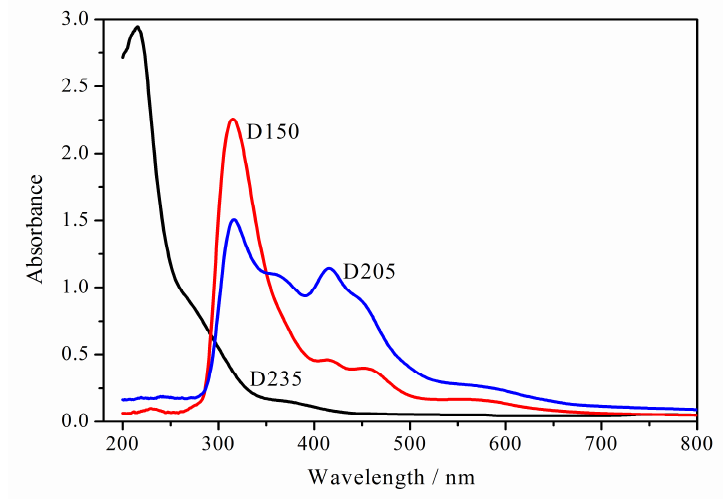
Figure 9. UV-visual spectroscopy of soluble polysulfides solutions at initial discharging to 2.35 V (D235), 2.05V (D215) and 1.50 V (D150),